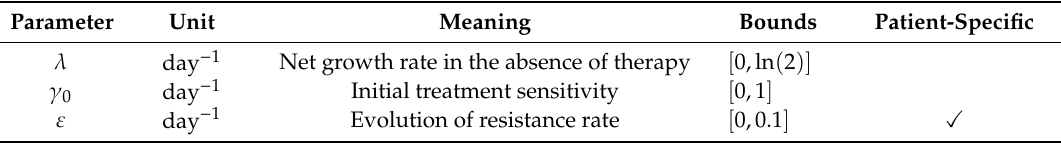
Table 1. Summary of model